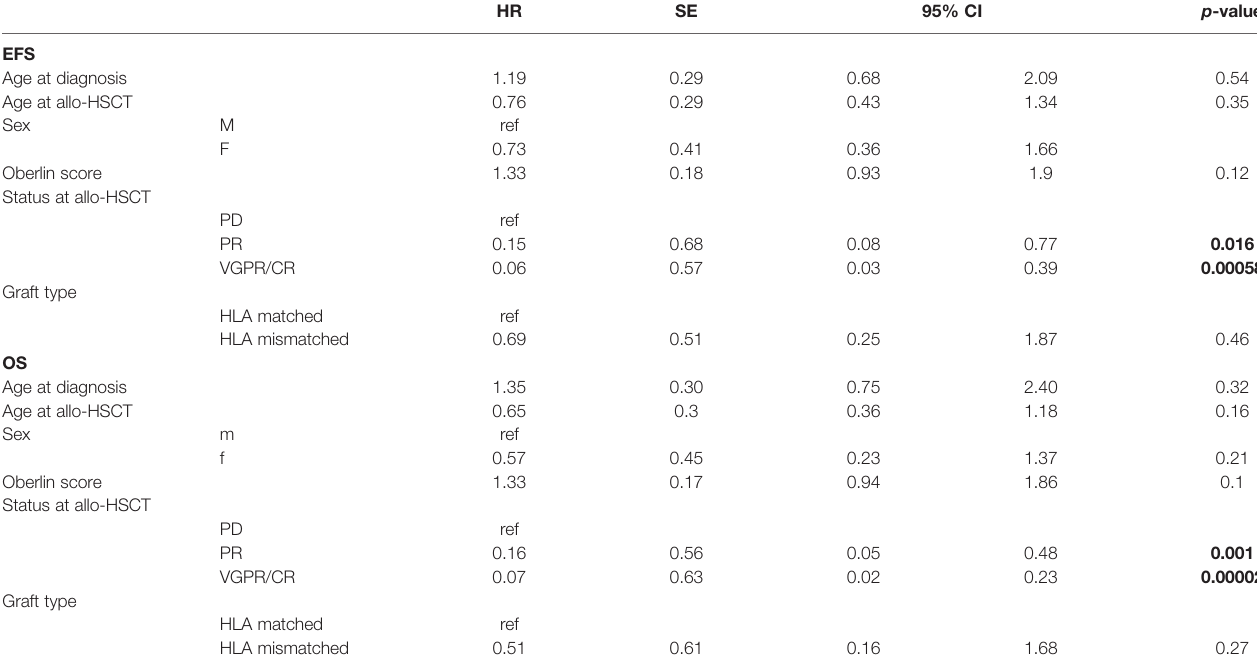
HR SE 95% CI p -value